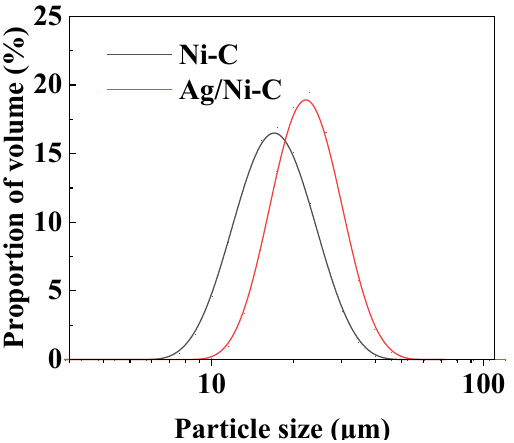
Figure 3. FT-IR spectra of Ni/C and Ag/Ni/C powders.